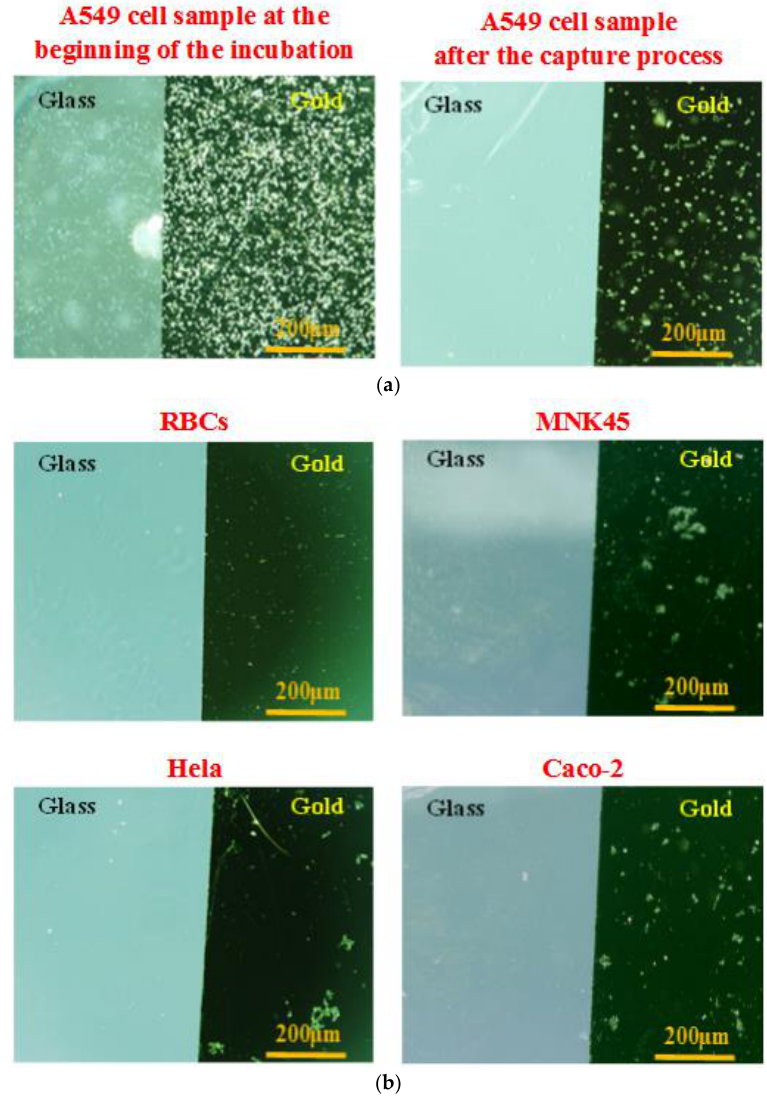
Figure 5. Microscopic images of the captured cells onto the aptamer-modified gold-glass substrates with different cell samples at the same cell concentration of 2 × 10 5 cells/mL, and the same conditions of the capture process: ( a ) Target cell sample, human non-small cell lung cancer cells (A549 adenocarcinoma cells) at the beginning of the cell incubation and after the cell capture process. ( b ) Control cell samples at the end of the cell capture process consist of red blood cells (RBCs), human cervical cancer cells (Hela adenocarcinoma cells), human gastric cancer cells (MKN45 adenocarcinoma cells), and human colorectal cancer cells (Caco-2 adenocarcinoma cells).